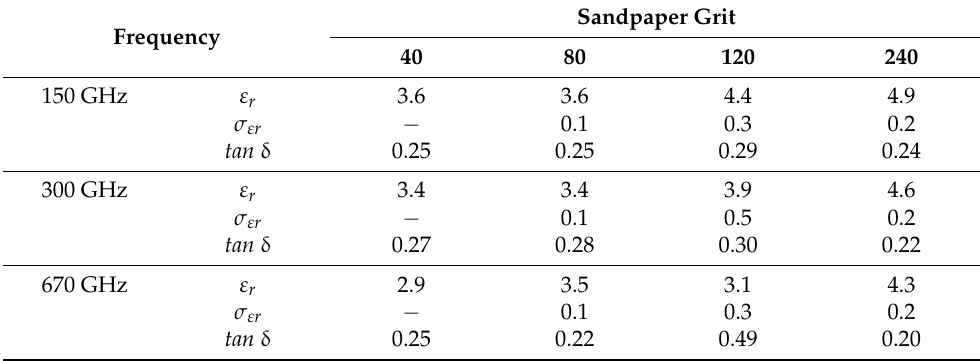
Table 1. Sandpaper relative permittivity.